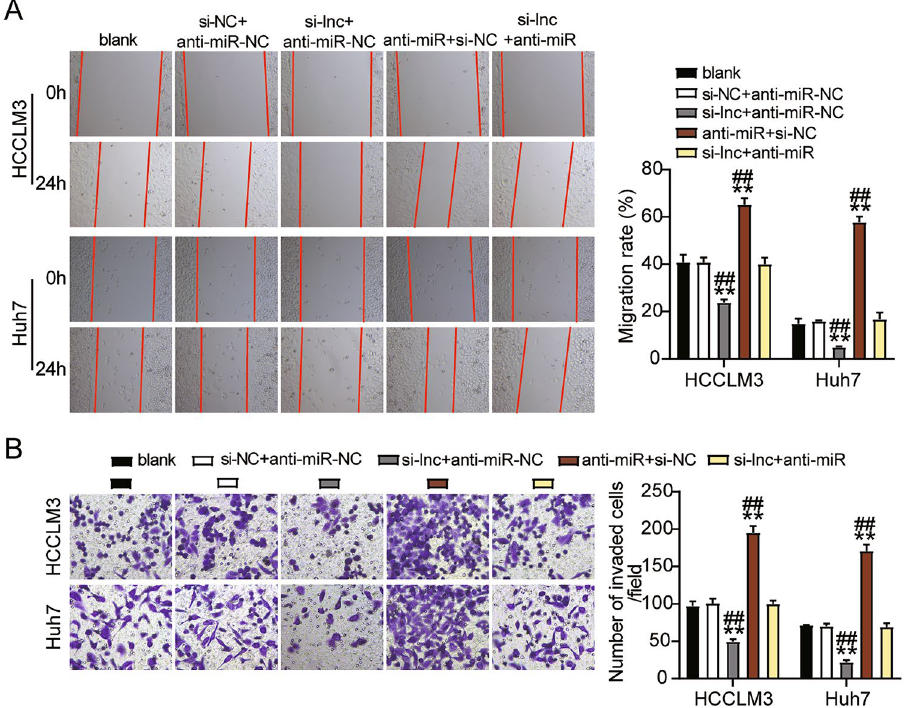
Figure 7. ST8SIA6-AS1 sponging miR-142-3p enhanced the cell migration and invasion of LIHC cells. ( A ) An assay for wound healing used to determine cell migration ability. ( B ) Cell invasion was detection using transwell assay. ## P < 0.001 compared with si-lnc + anti-miR; **P < 0.001 compared with blank. NC: negative control; blank: blank control; anti-miR: miR-142-3p inhibitor; Si-lnc: SiRNA-ST8SIA6-AS1; Si-lnc + anti-miR: SiRNA- ST8SIA6-AS1 + miR-142-3p